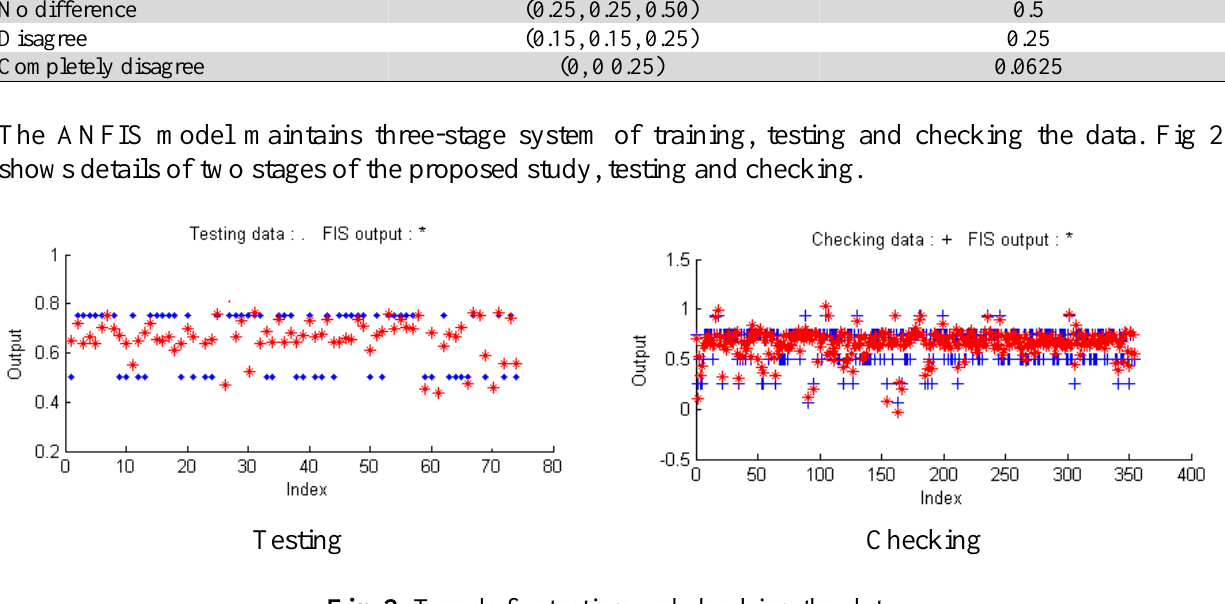
Fig. 2. Trends for testing and checking the